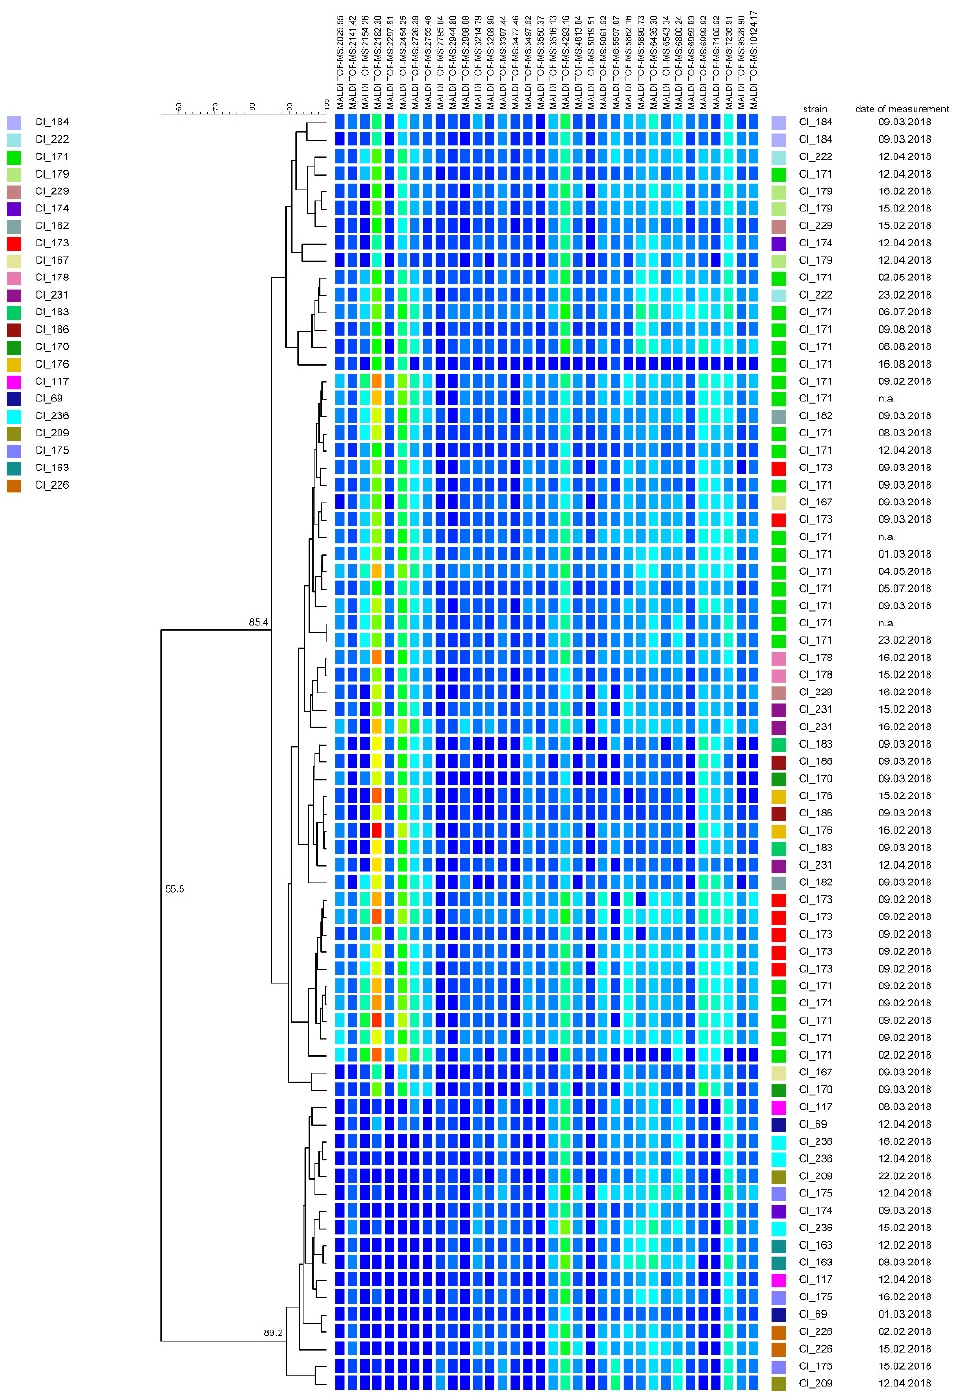
Figure 1. Dendrogram obtained from repeated matrix-assisted laser desorption ionization—time of flight mass spectrometry (MALDI-TOF MS) fingerprinting of 22 C. tyrobutyricum strains. The dendrogram was constructed using the unweighted pair group method with arithmetic mean (UPGMA) with similarity levels expressed as percentage values of the Pearson correlation coefficient. The color shading indicates peak intensity (from low to high intensity: dark blue, green, yellow, red); n.a.: not available.